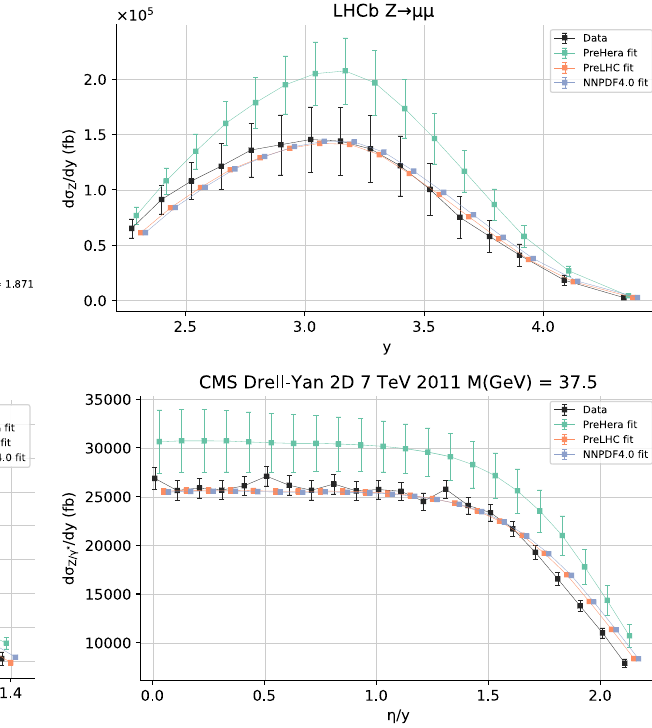
Fig. 30 Comparison of the theoretical predictions including PDF uncertainties from the pre-HERA and pre-LHC PDF sets based on NNPDF4.0 methodology and those of the global fit to four represen- tative measurements: t HERA NC structure functions, dimuon rapidity distributions in Z production at LHCb, top rapidity distributions in ATLAS t ¯ t production, and the dilepton rapidity distribution for CMS